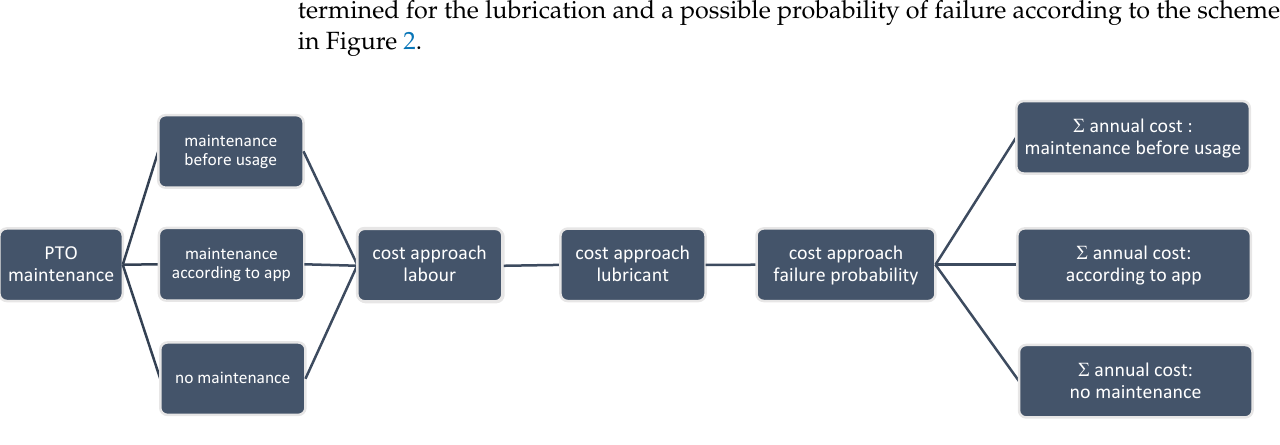
Figure 2. Cost calculation schematic for the maintenance of a PTO shaft for three maintenance scenarios.